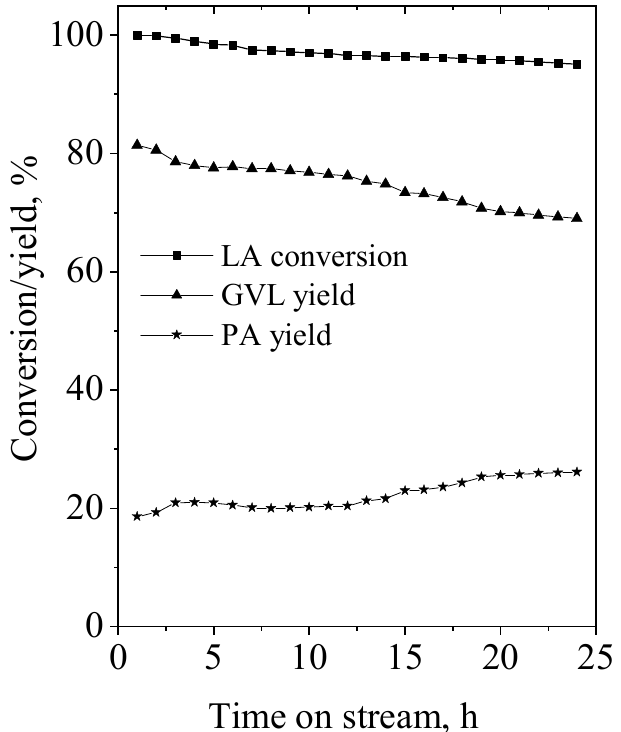
Figure 10. LA conversion and yield of products with time on stream on the CuNi-KZ catalyst at 250 ° C.